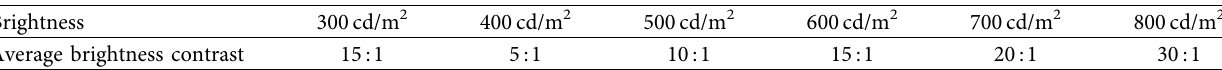
Figure 2: Analysis chart of average score and brightness change trend of visual comfort evaluation. Table 6: Large probability distribution of brightness comparison data.